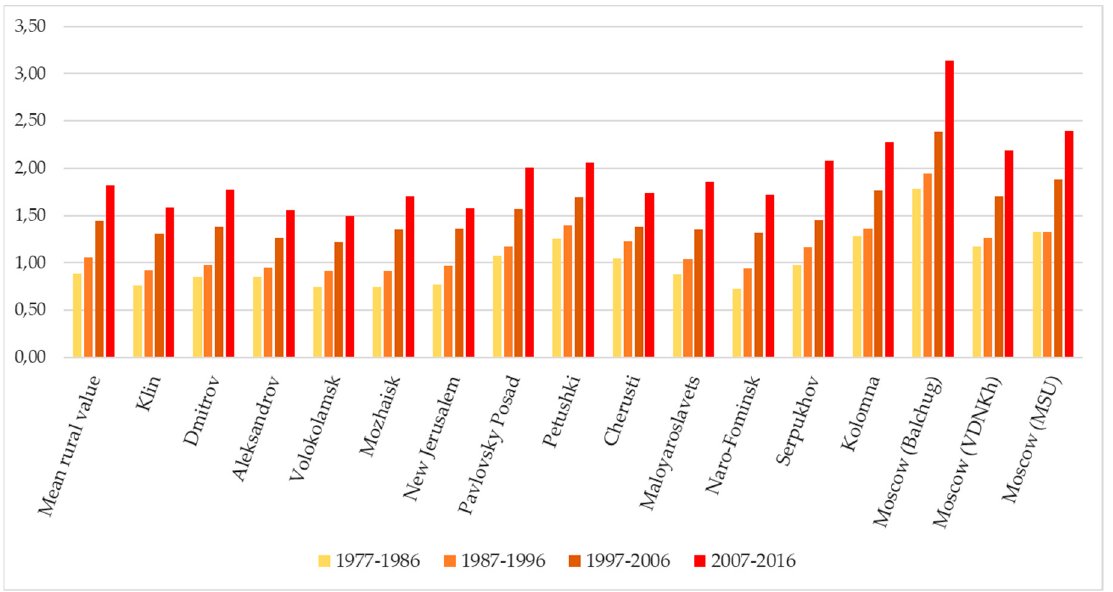
Figure 11. Changes in the degree of favorability of thermal regime for the development of the vivax malaria parasite in the Moscow region over the 10-year periods between 1977 and 2016.